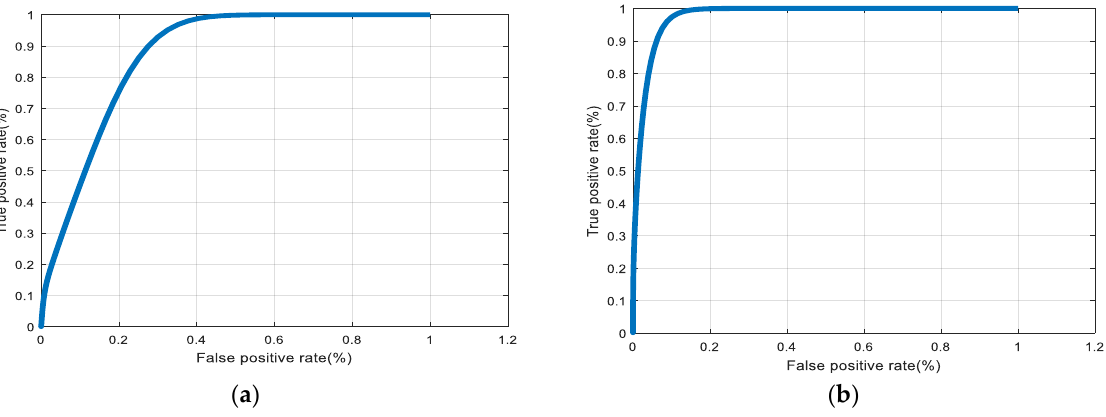
Figure 18. ROC curves for the system using an encrypted kernel with the IWT with similar keys of encryption with a noise variance of ( a ) 0.01, and ( b ) 0.02.